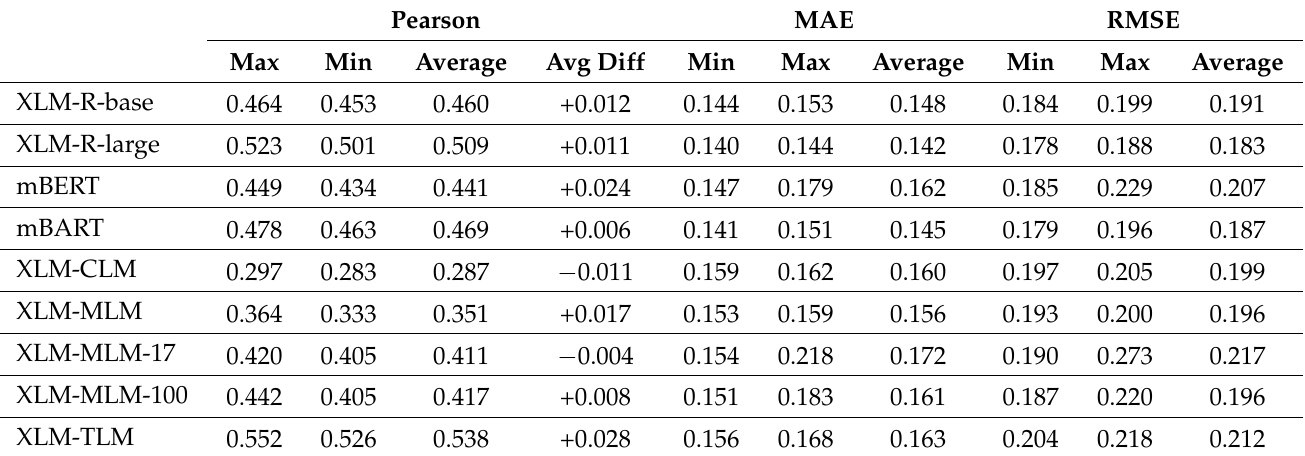
Table 5. Results of mPLM finetuning with inverted inputs for the test set of WMT20 sub-task 2.